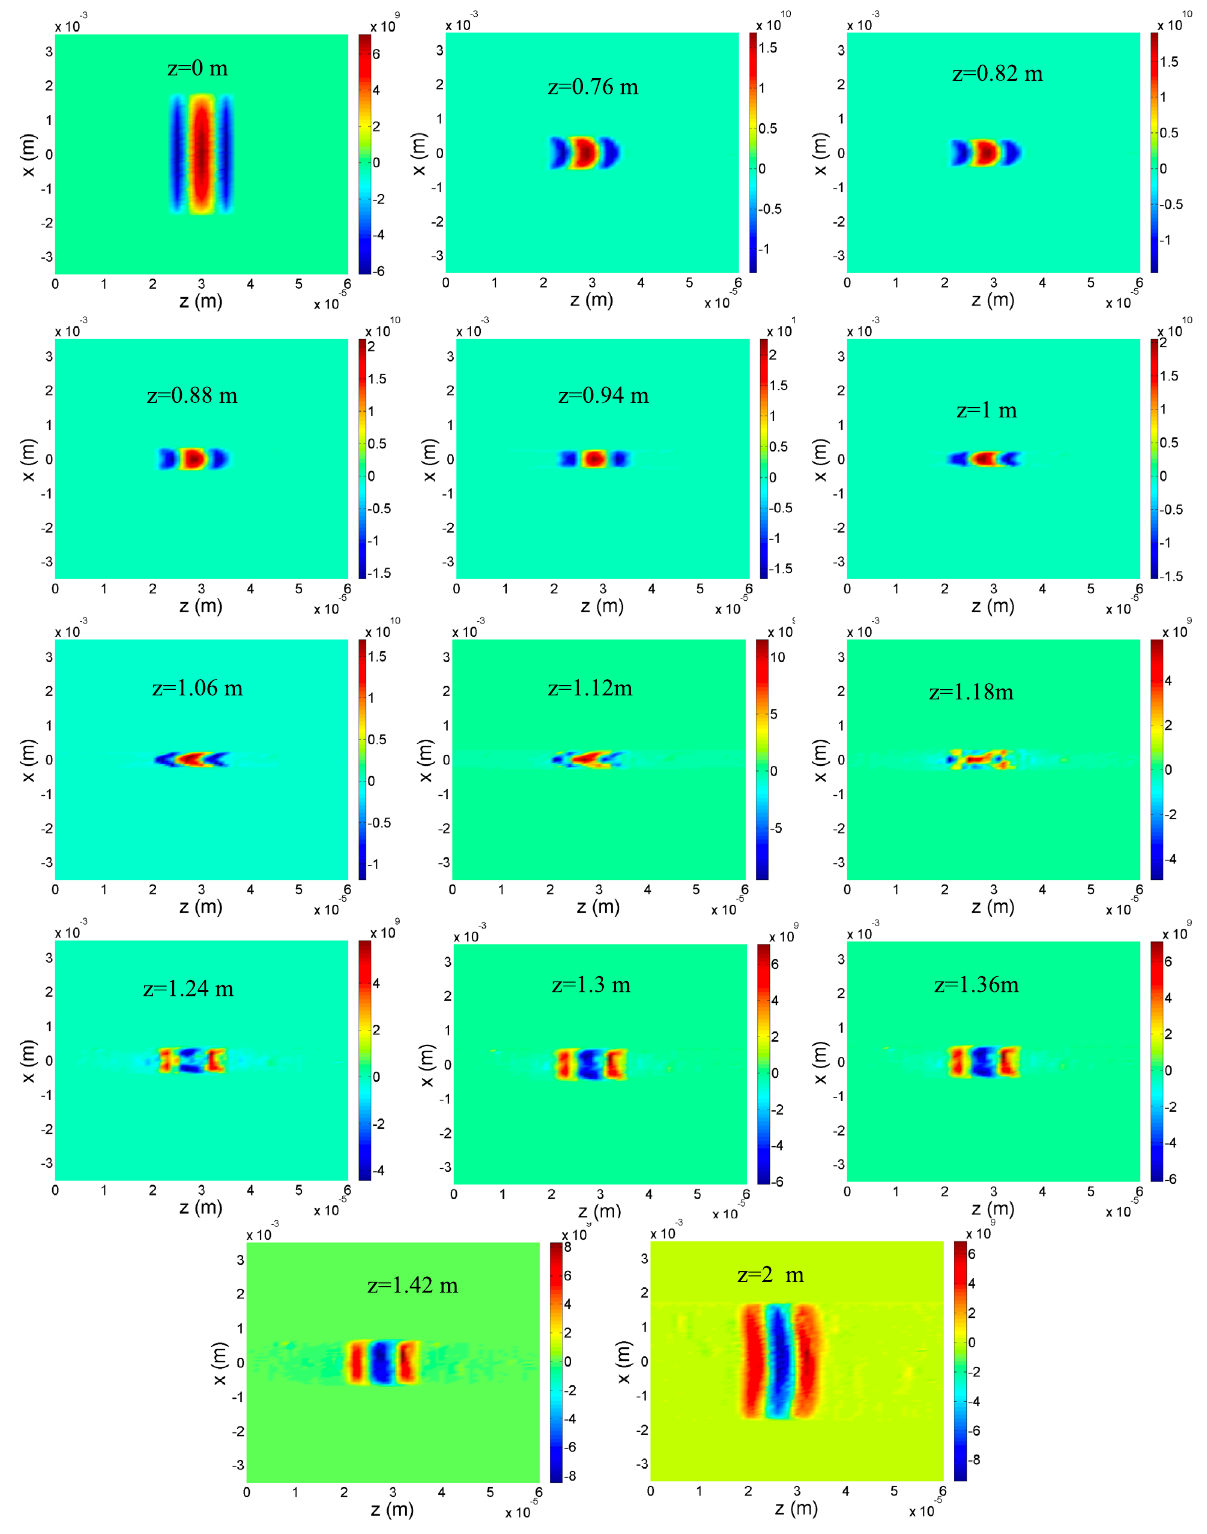
FIG. 9. Details of the single spike evolution in the first cell of the PCI lattice of case 1. Only the ac portion of the density is shown: red color corresponds to increased beam density and blue to reduced beam density with color density normalized to maximum values. Appearance of Langmuir waves with varying transverse structures can be seen in profiles taken from z ¼ 1 . 12 m to z ¼ 1 . 36 m. Locations for taking profiles are chosen to illustrate the key processes occurring during the PCI process, including changes in the “ wavefront ” curvatures and in the transverse